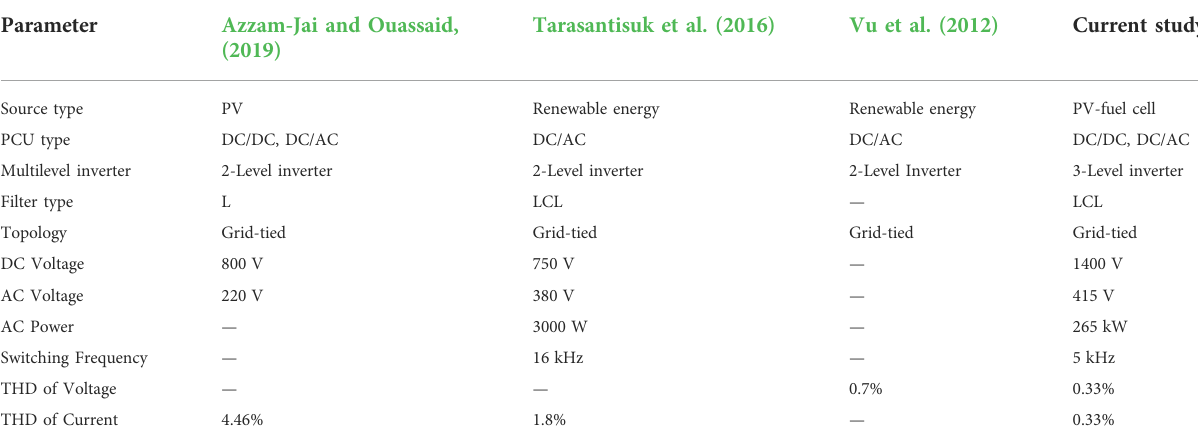
TABLE 7 Comparing study against some related research in literature. Parameter Azzam-Jai and Ouassaid, Tarasantisuk et al. (2016) Vu et al. (2012) Current (2019)